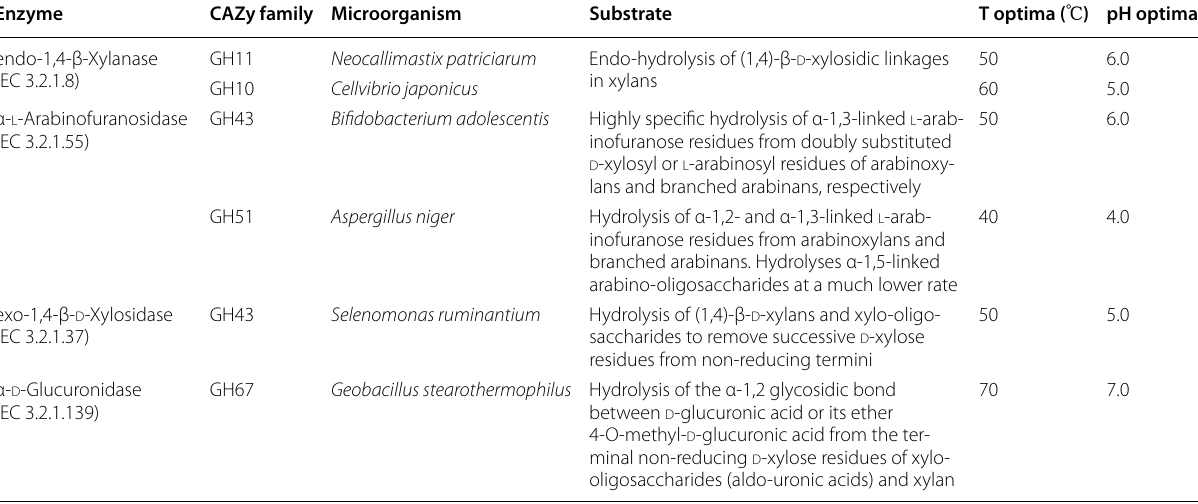
Table 1 Summary of enzymes characteristics